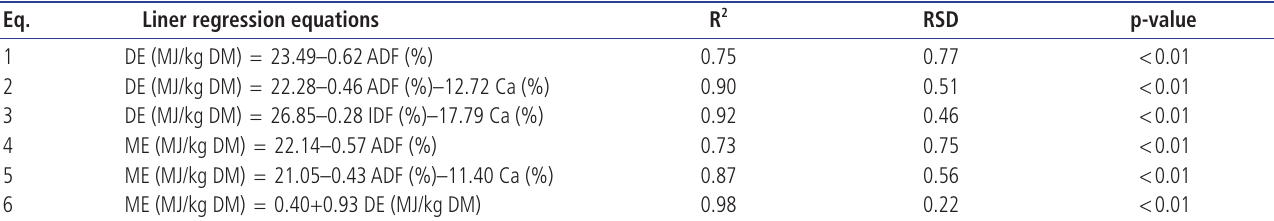
Table 7. Stepwise regression equations for digestible energy (DE) and metabolizable energy (ME) based upon the chemical characteristics of the 10 corn germ meal samples 1)